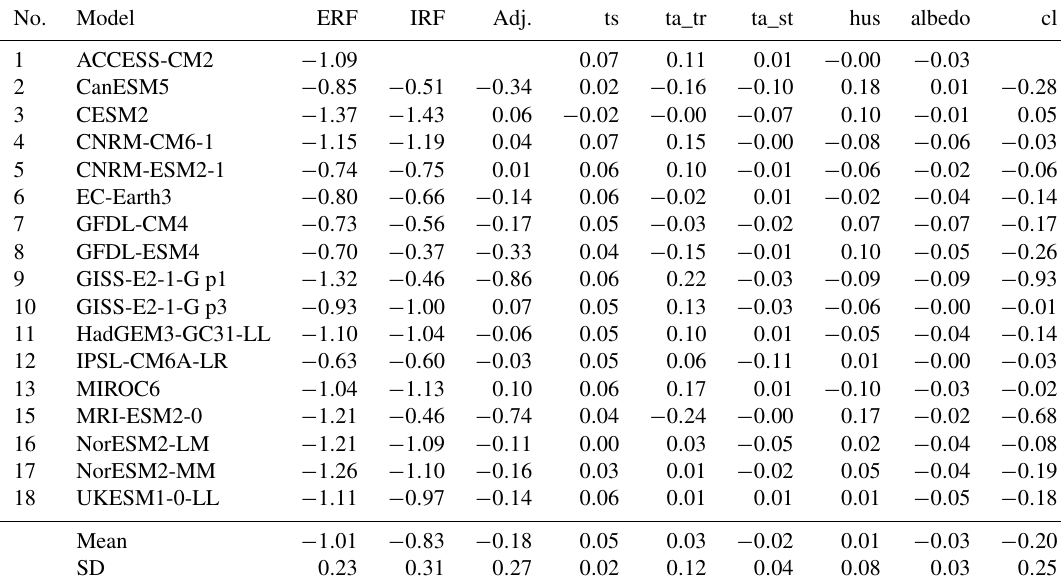
Table 5. As for Table 3 but for 1850–2014 aerosol